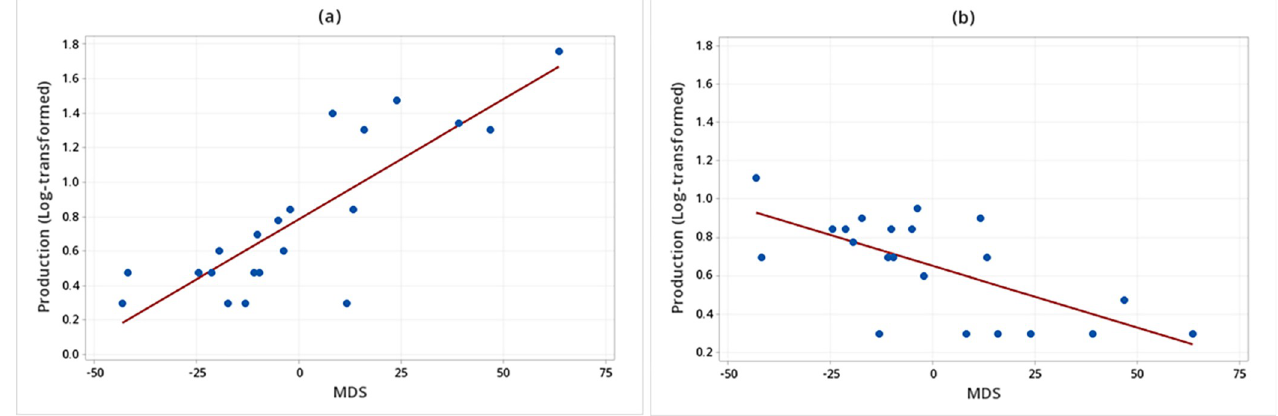
Fig 4. Relationship between the sender’s social rank (MDS) and the production of multimodal signals. (a) White-lipped peccaries (N = 21) were displaying threatening behaviors. (b) Animals were displaying submissive behaviors.